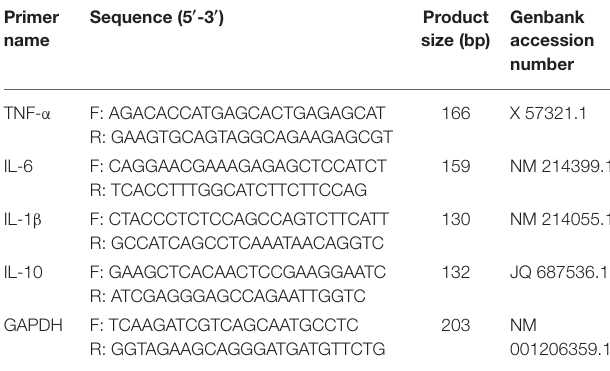
TABLE 2 | Primer sequences used for the reverse transcription-polymerase chain reaction (RT-PCR)